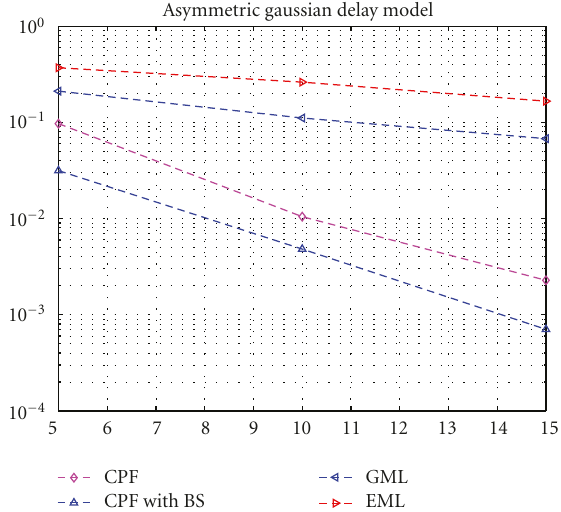
Figure 8: MSEs of clock o ff set estimators for Gamma random delay = 1], and 2 exchange message errors [ α 1 = 2, β 1